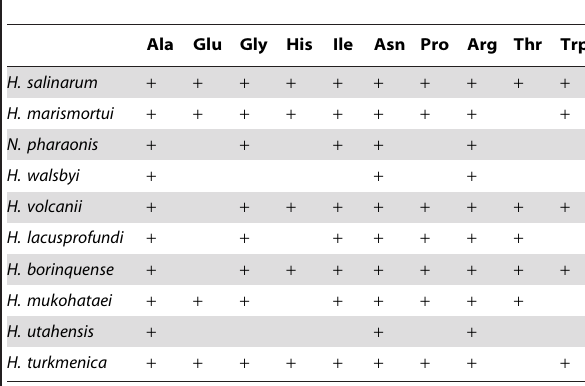
Table 3. Amino acid degradation pathways in haloarchaea.